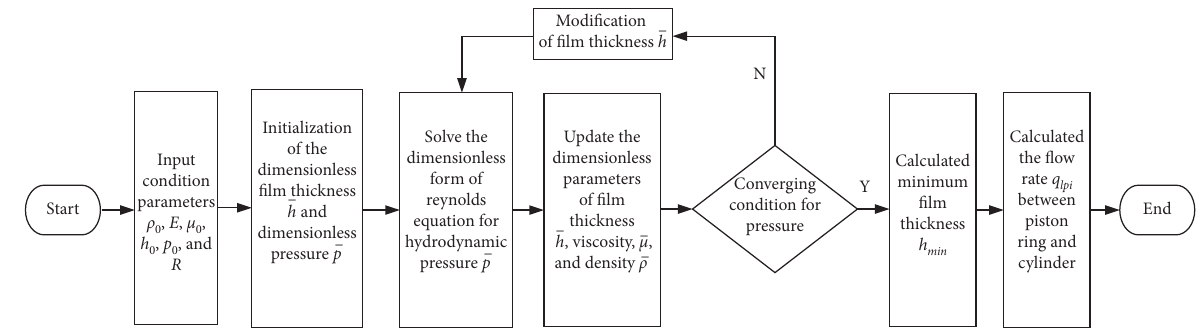
Figure 4: Flow chart of the calculation process. Table 1: Simulation parameters